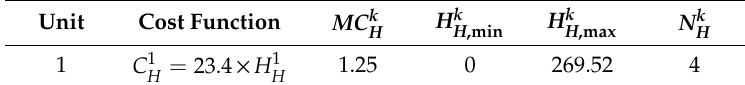
Table 3. Data of the heat-only